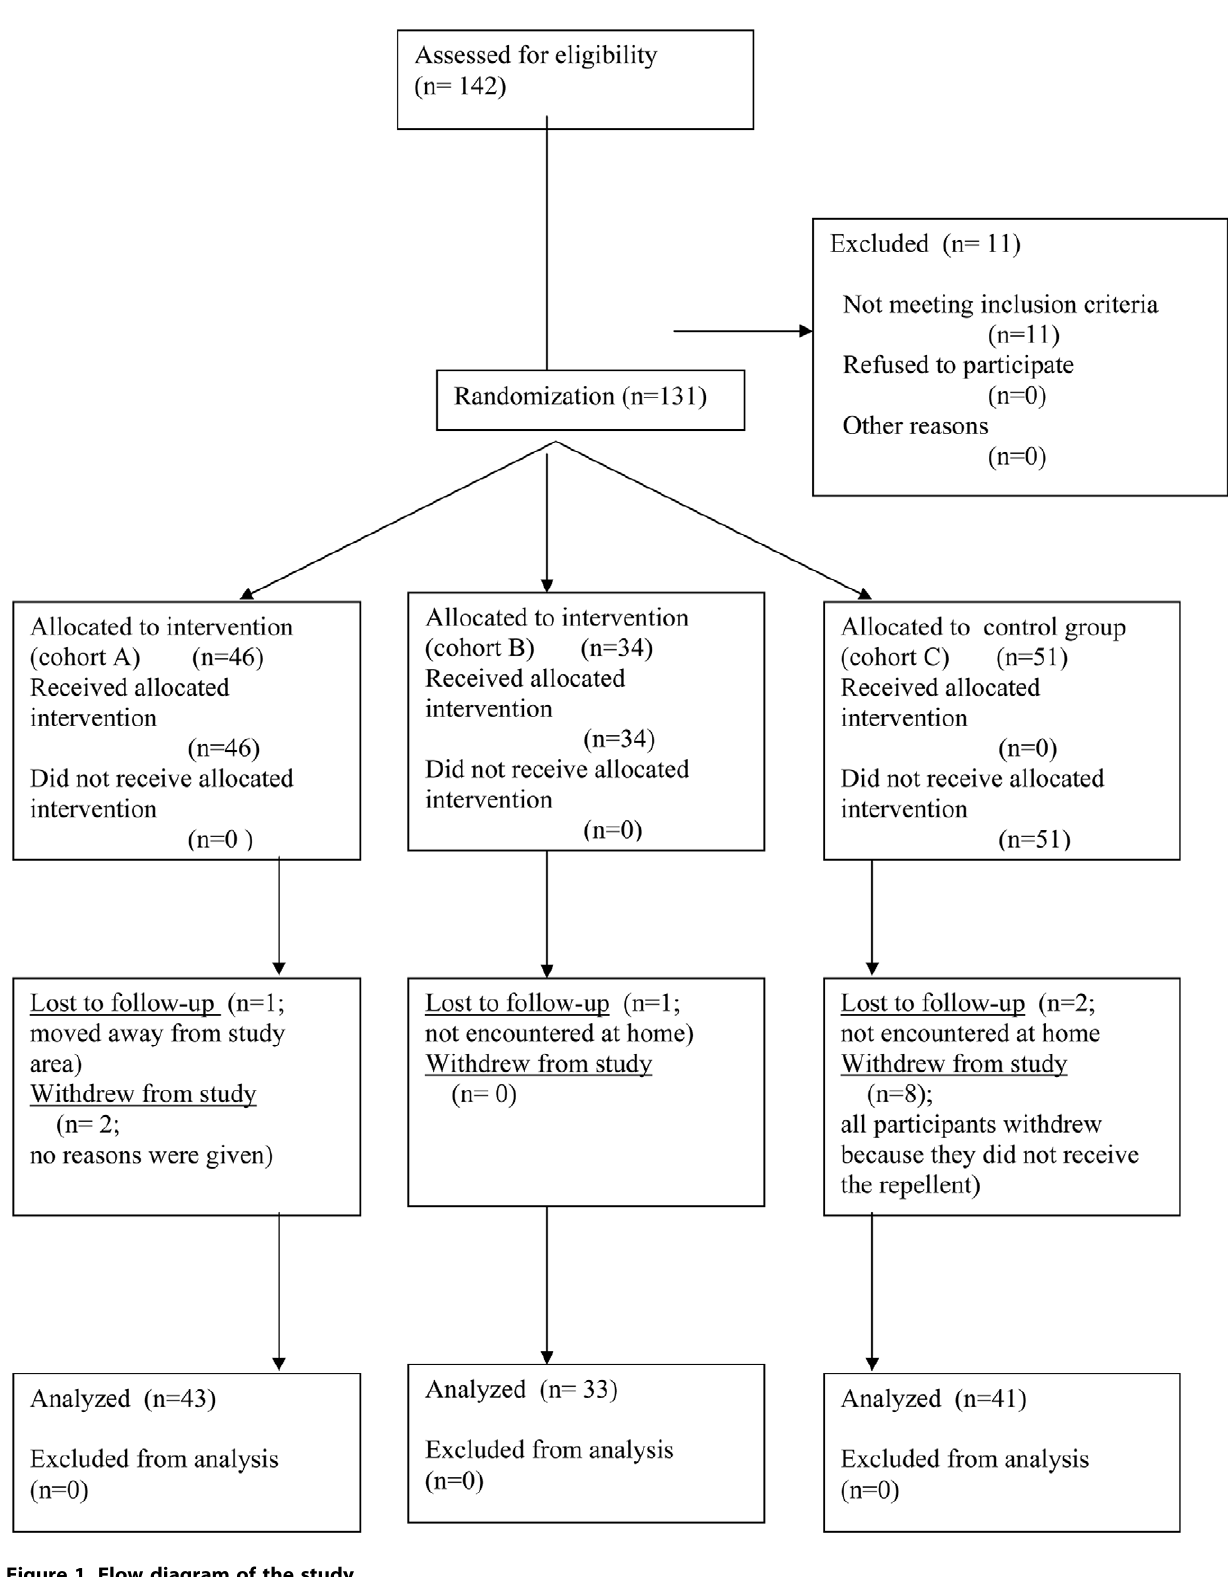
Figure 1. Flow diagram of the study.